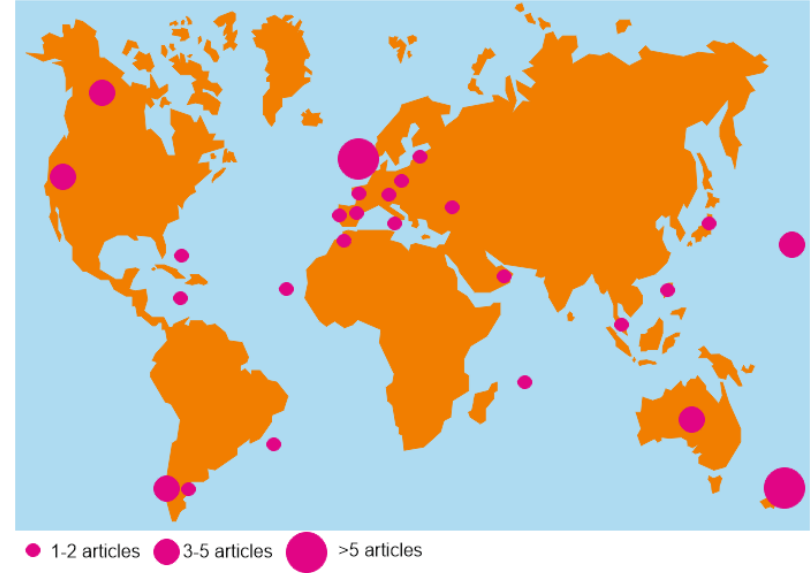
Figure 4. Geographical distribution of megaclasts studied during 2000 – 2017 (created by authors).